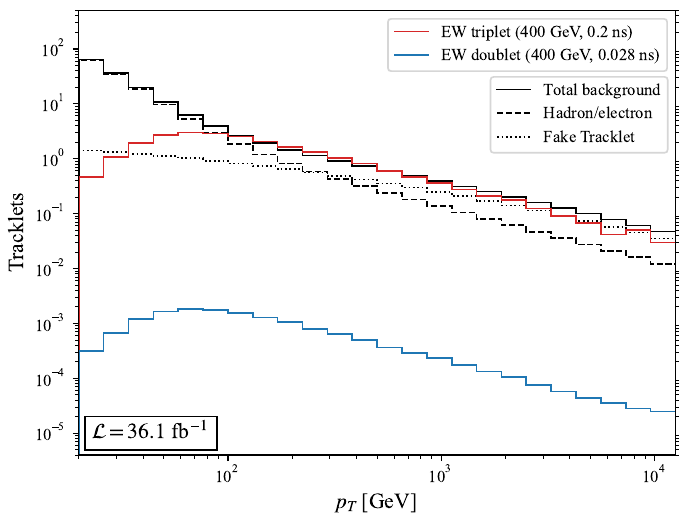
Figure 4 . Tracklet p T distributions normalized to a total luminosity of 36.1 fb − 1 for EW triplet ( m , τ ) = (400 GeV , 0 . 2 ns) , EW doublet ( m χ ± χ ± category, in the high- E miss region. T